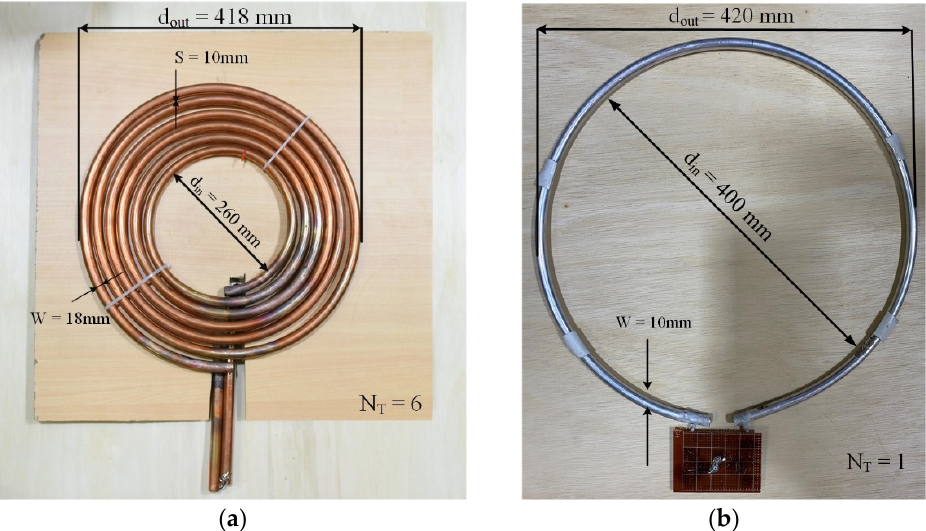
Figure 5. Coil design specification for ( a ) transmitter (MTSCC) and ( b ) receiver (STLAC) coils.